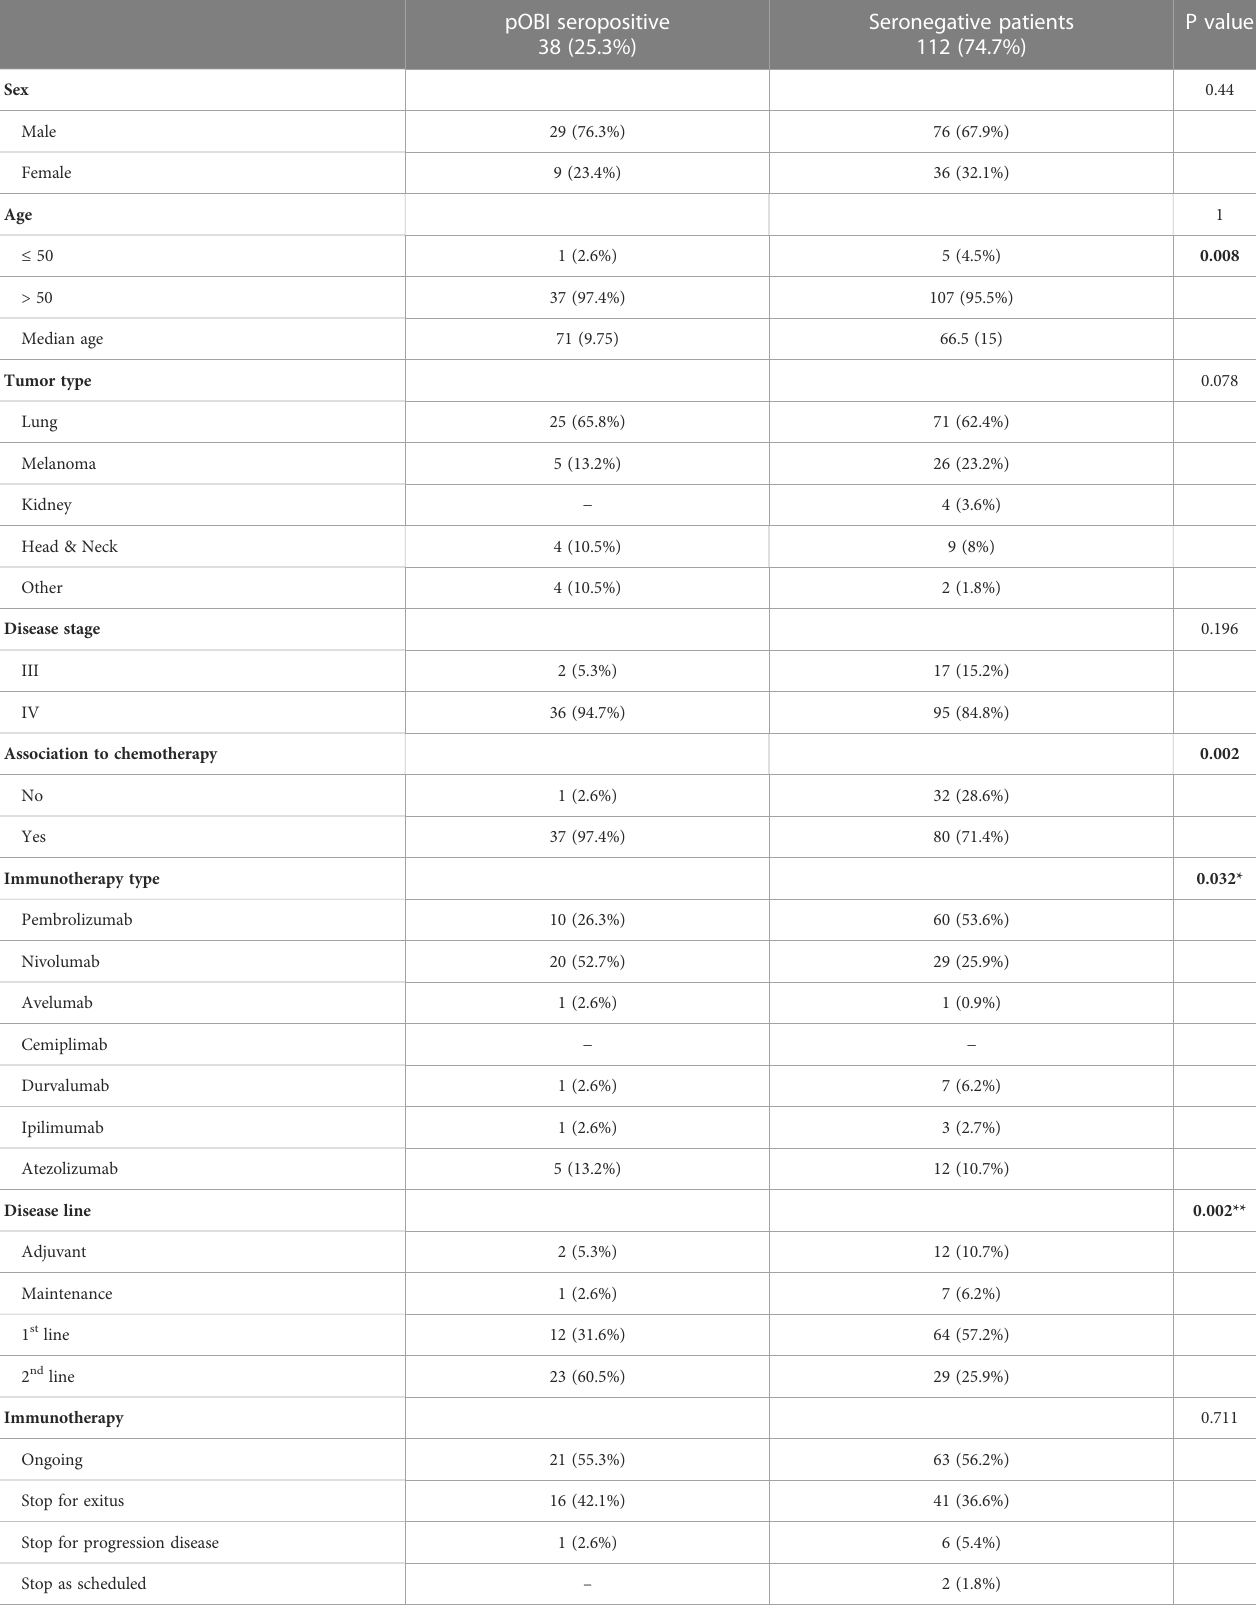
TABLE 3 Univariate analysis